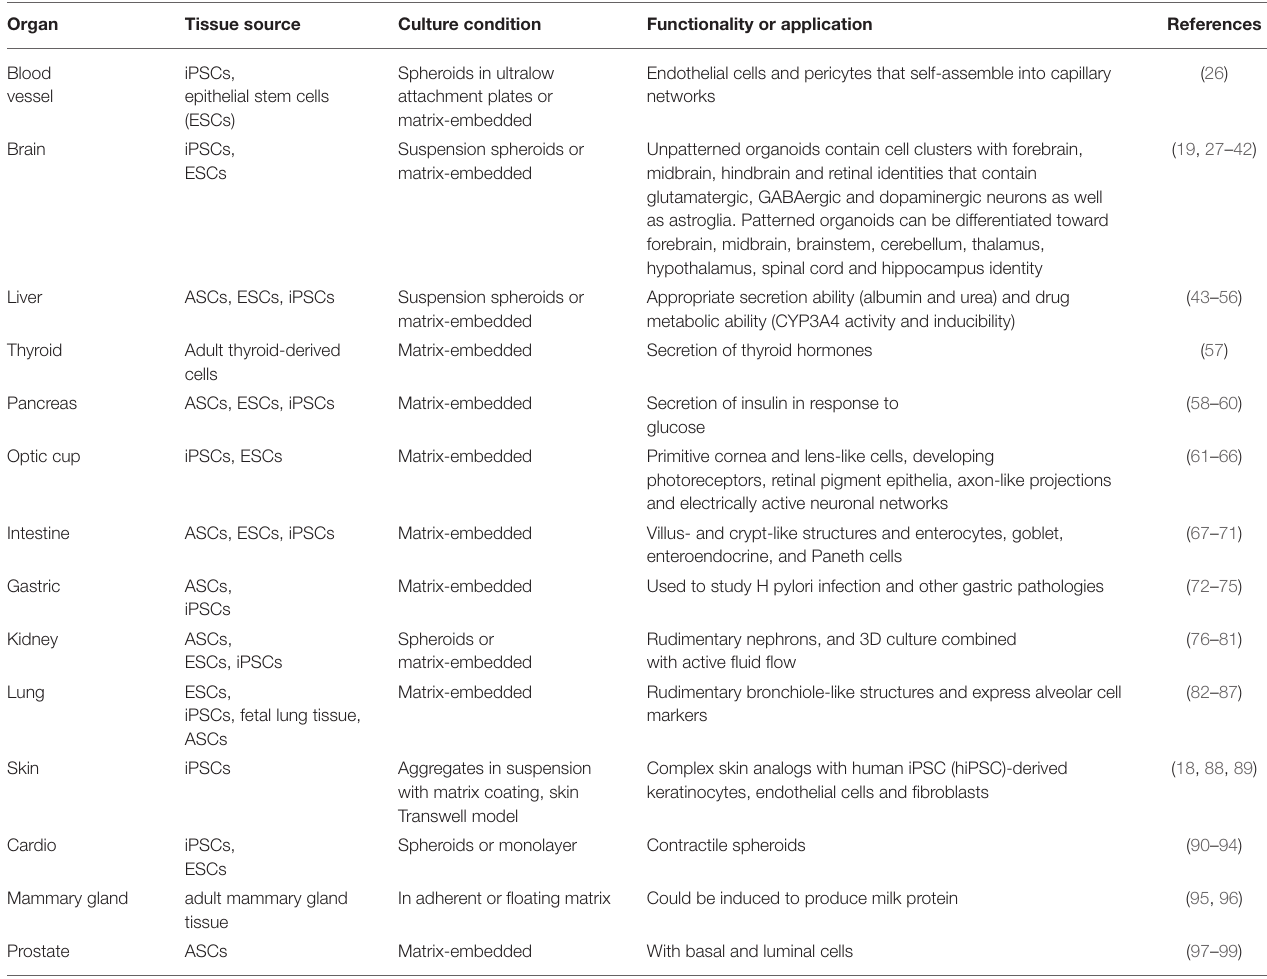
TABLE 1 | Overview of human organoids generated in static in vitro